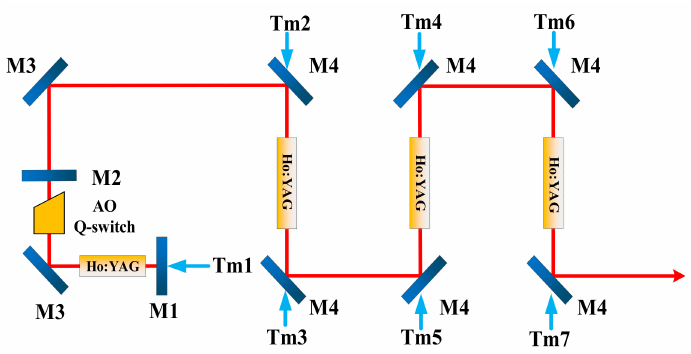
Figure 1. Experimental setup of three-stage Ho:YAG MOPA system. The three-stage Ho:YAG MOPA system was designed and operated at a PRF of 1 kHz. The three Ho:YAG crystals with a dopant concentration of 0.3%, diameter of 5 mm, and length of 70 mm were dual-ended pumped by six Tm:YLF lasers. The output powers of the six Tm:YLF lasers were about 40 W. The beam diameters of the pump in the three Ho:YAG crystals were 0.83, 1.4, and 1.9 mm,